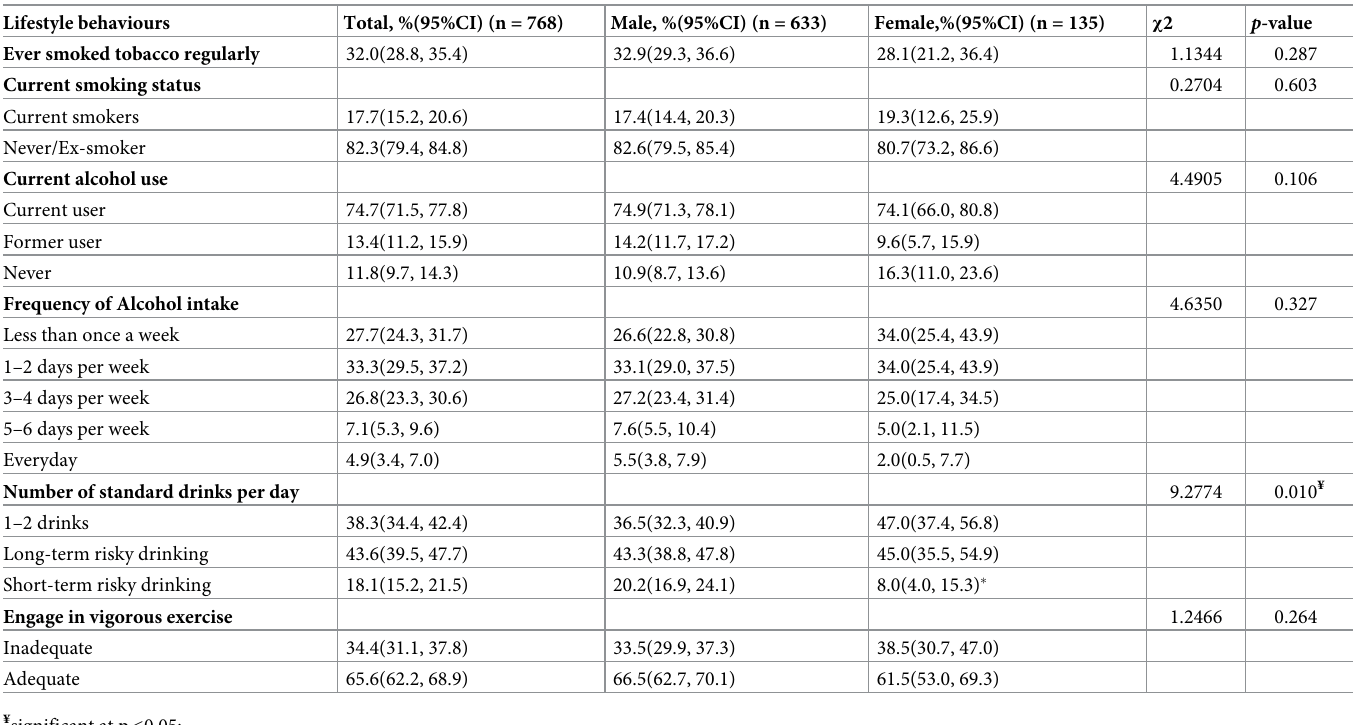
Table 1. Lifestyle behaviours distribution across gender of FIFO